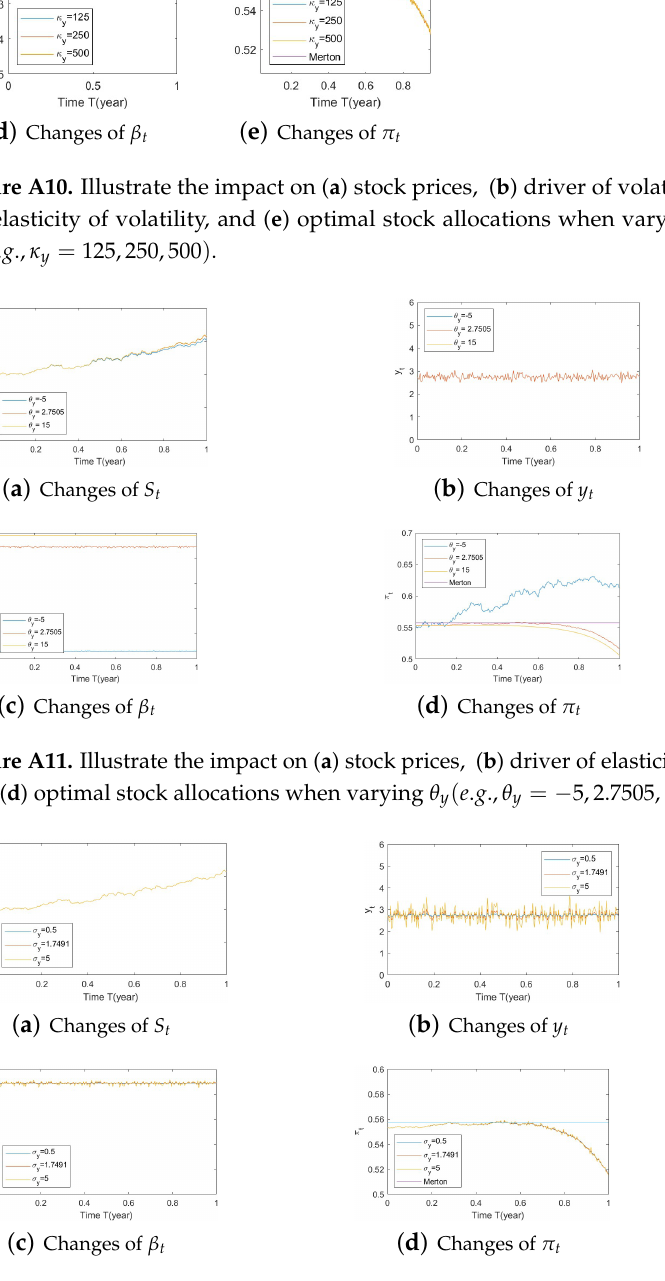
Figure A12. Illustrate the impact on ( a ) stock prices, ( b ) driver of elasticity, ( c ) elasticity of volatility, and ( d ) optimal stock allocations when varying σ y ( e . g ., σ y = 0.5,1.7491,5 ) .